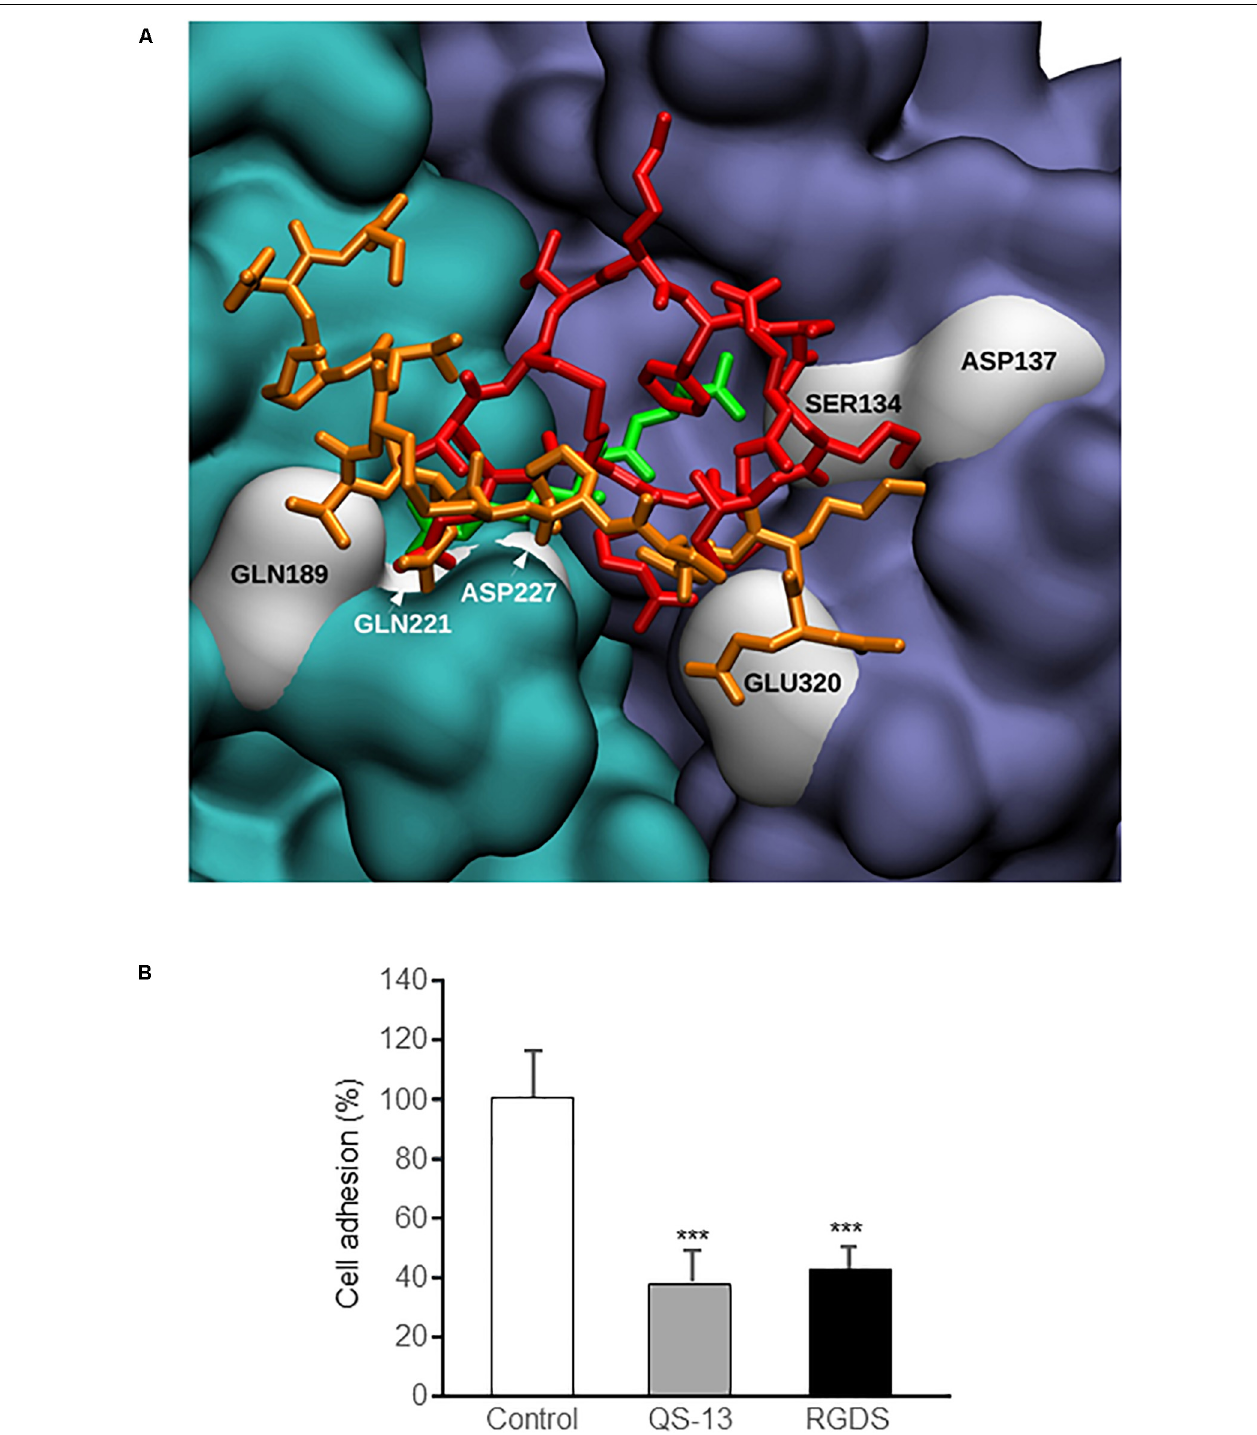
FIGURE 5 | Comparison of QS-13 and RGD theoretical binding sites on α 5 β 1 integrin and in vitro confirmation. (A) α 5 β 1 integrin is represented using the Quick Surface scheme and a color code related to the nature of the subunit (cyan for α 5 and magenta for β 1 ). The best docking poses of the two QS-13 conformations are superimposed with the conformation of the RDG peptide (from the experimental complex corresponding to the PDB ID 3VI4 solved with X-ray experiments) and depicted with a color coded (first QS-13 conformation extracted from the MD in red, the second in orange and RGD peptide in green) Licorice representation. Residues from the integrin making contacts with QS-13 (as evidenced in Figure 3 ) are highlighted with white surface representation and labeled. (B) HUVECs were pre-incubated for 30 min with culture medium alone (control), culture medium supplemented with RGDS peptide (20 µ g/mL) or with QS-13 (20 µ g/mL) and adhesion was measured. Three independent experiments were carried out. The histogram represents the means ± SD of the more representative one. n = 8, *** p < 0.001.